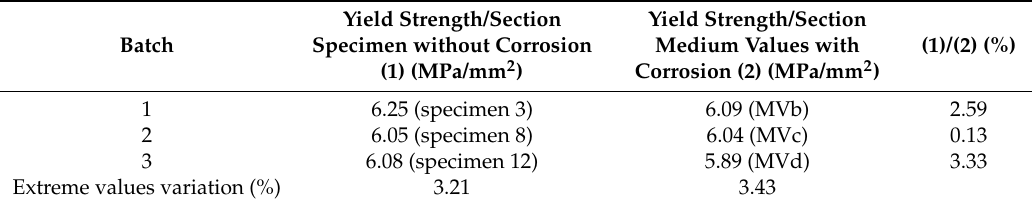
Table 8. Yield strength/section values per specimen and medium values vs. batch.